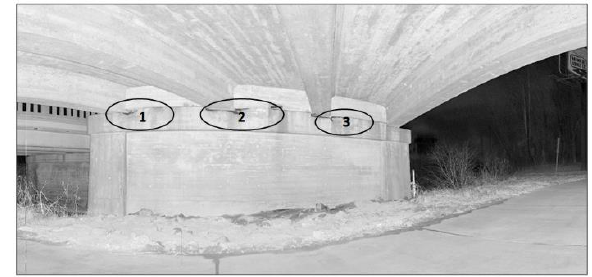
Figure 7. LiDAR scan for damage detection in bridge **0147 (Charlotte, NC)